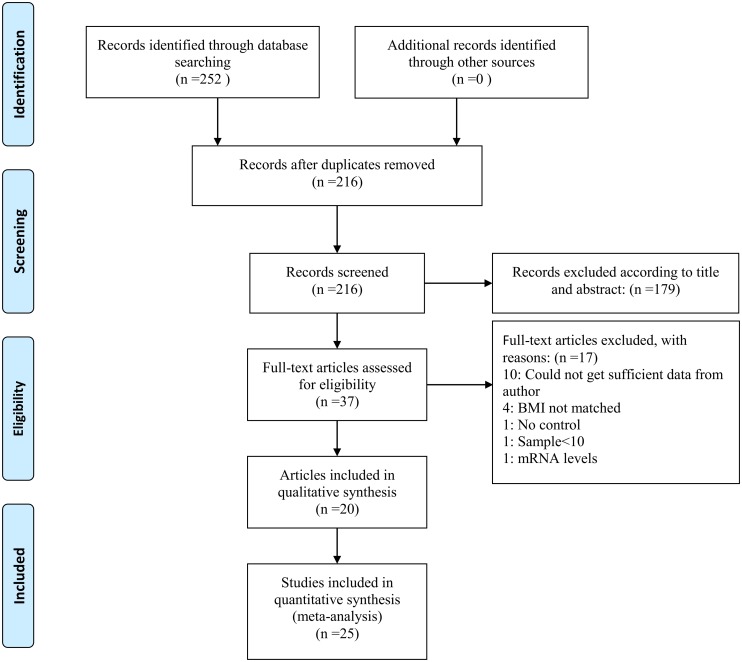
Flow diagram of included studies for this meta-analysis.